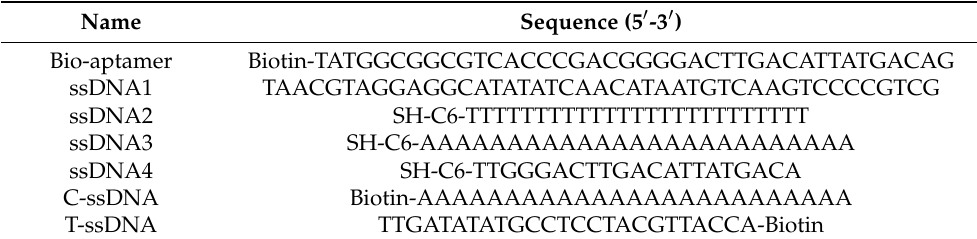
Table 1. The sequence of bio–aptamers, ssDNA was used in this